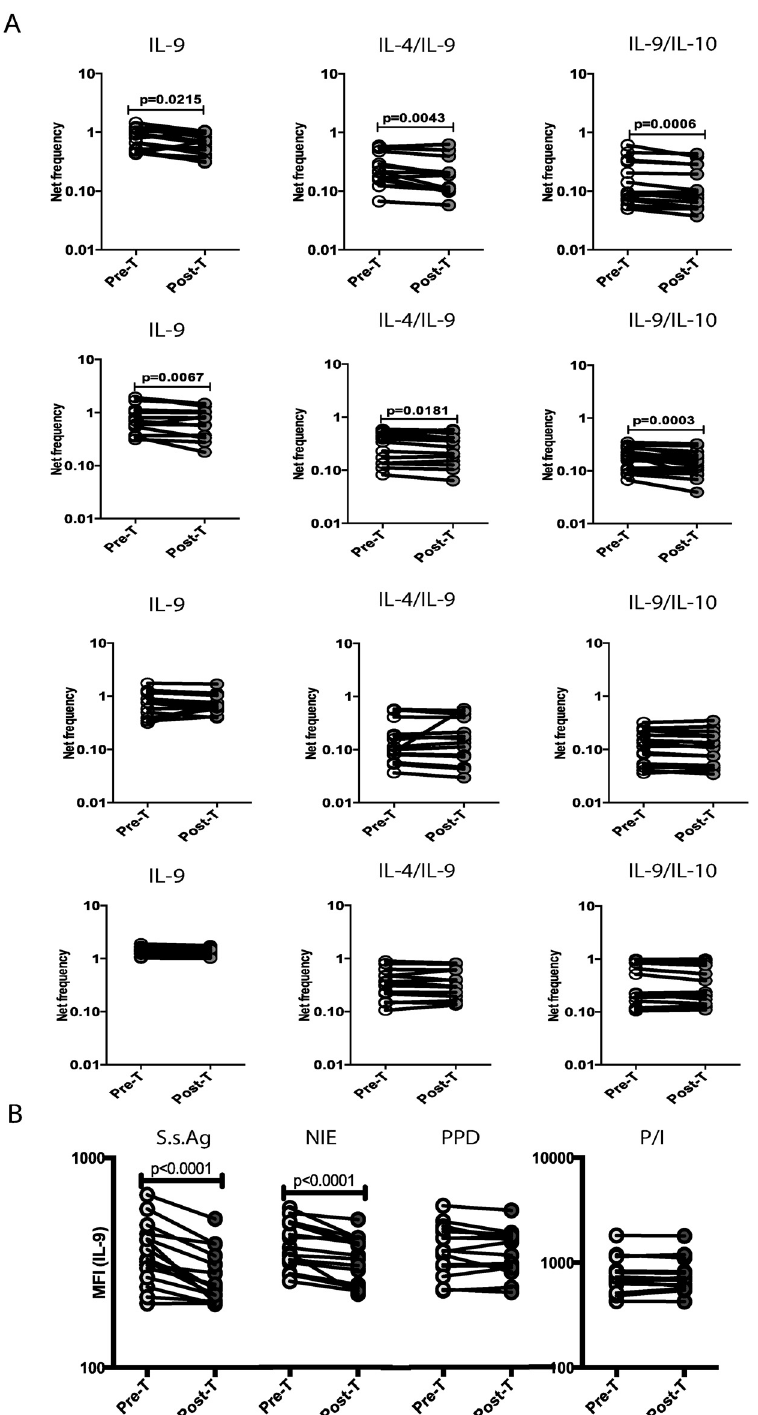
Fig 4. Treatment of Strongyloides infection is associated with diminished frequencies of antigen- specific Th9 cells. (A) The frequencies of Th9 cells following stimulation with SsAg, NIE, PPD and P/I before and after treatment with a standard dose of ivermectin and albendazole in a subset of INF individuals (n = 15). (B) The MFI of IL-9 expression following stimulation with SsAg, NIE, PPD and P/I before and after treatment with a standard dose of ivermectin and albendazole in a subset of INF individuals (n = 15). Antigen-stimulated frequencies are shown as net frequencies with the baseline levels subtracted. Each line represents a single individual. P values were calculated using the Wilcoxon signed rank